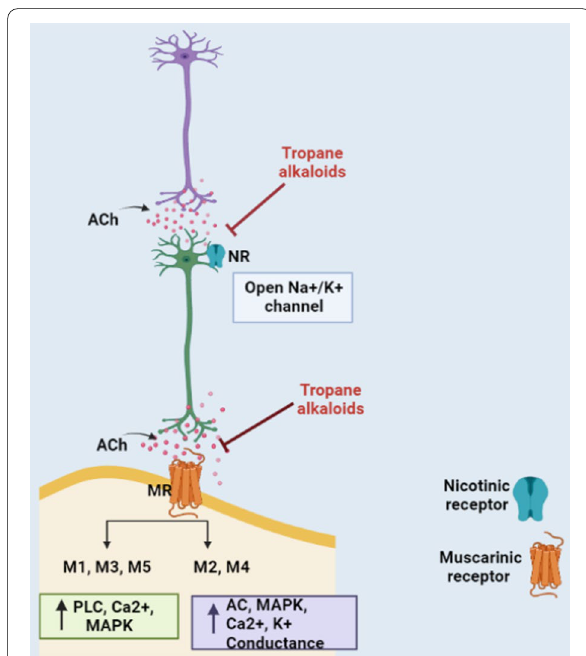
Fig. 1 Anticholinergic Action of Tropane Alkaloids. Tropane alkaloids are anticholinergic in action. TAs competitively bind to muscarinic and/or nicotinic receptors and block ACh transmission. MR: Muscarinic receptor; NR: Nicotinic receptor; ACh: Acetylcholine; PLC: Phospholipase C; AC: Adenylyl cyclase; MAPK: Mitogen-activated protein kinase [Prepared using